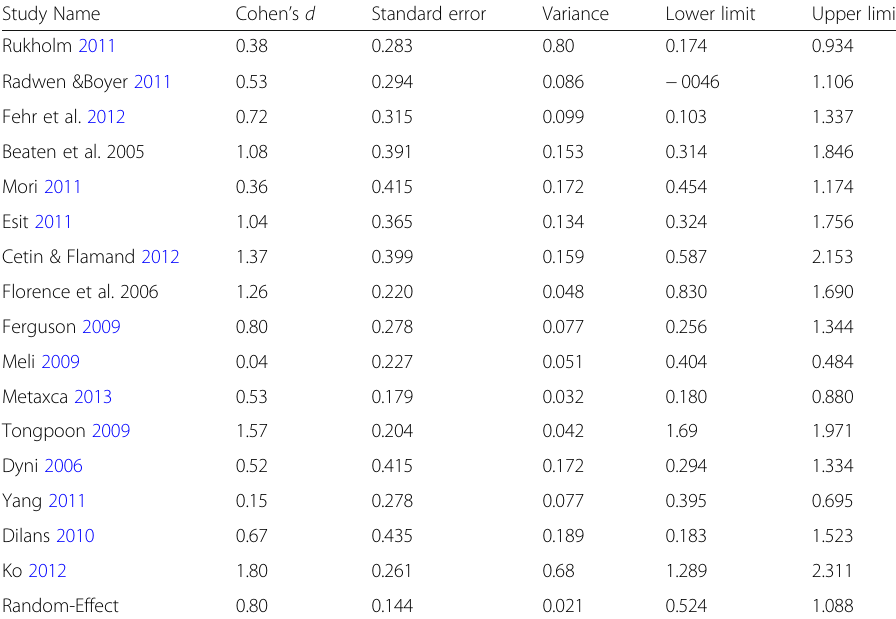
Table 2 the Cohen ‘ s d, upper limit and lower